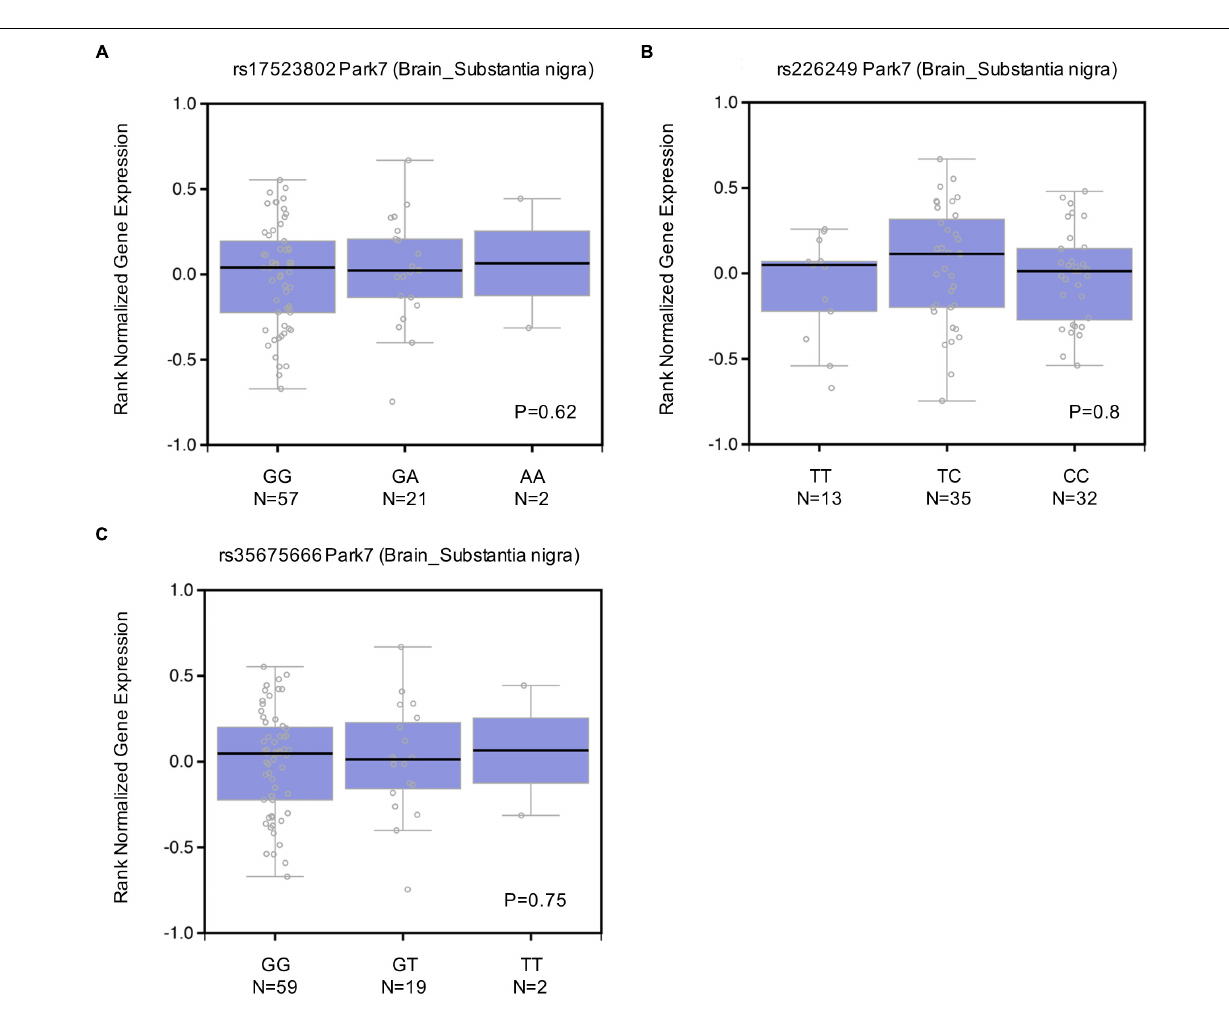
Frontiers in Aging Neuroscience |